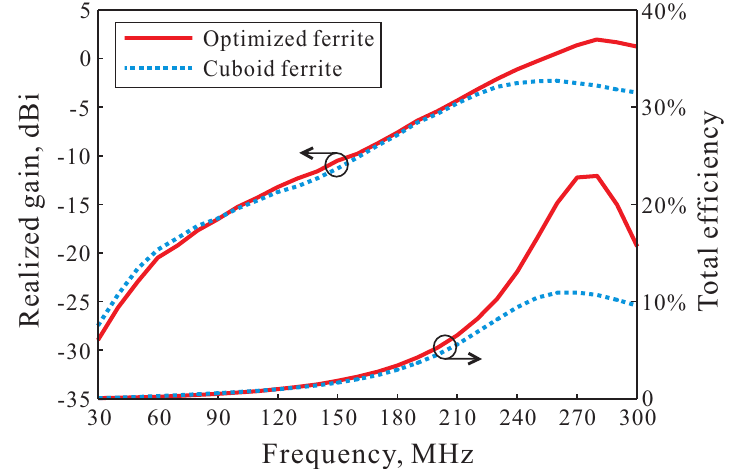
Figure 5. Simulated realized peak gains and efficiency rates of the Spidron fractal loop antenna with optimized and cuboid